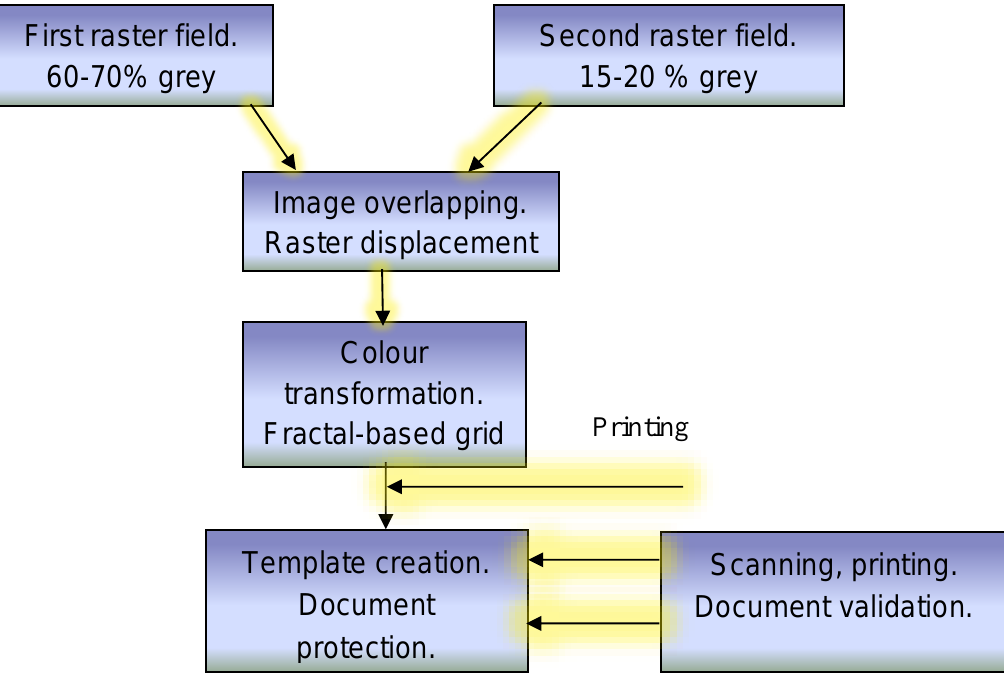
Figure 3. Flowchart of a method of constructing latent Figure 3 . Flowchart of a method of constructing latent elements 194